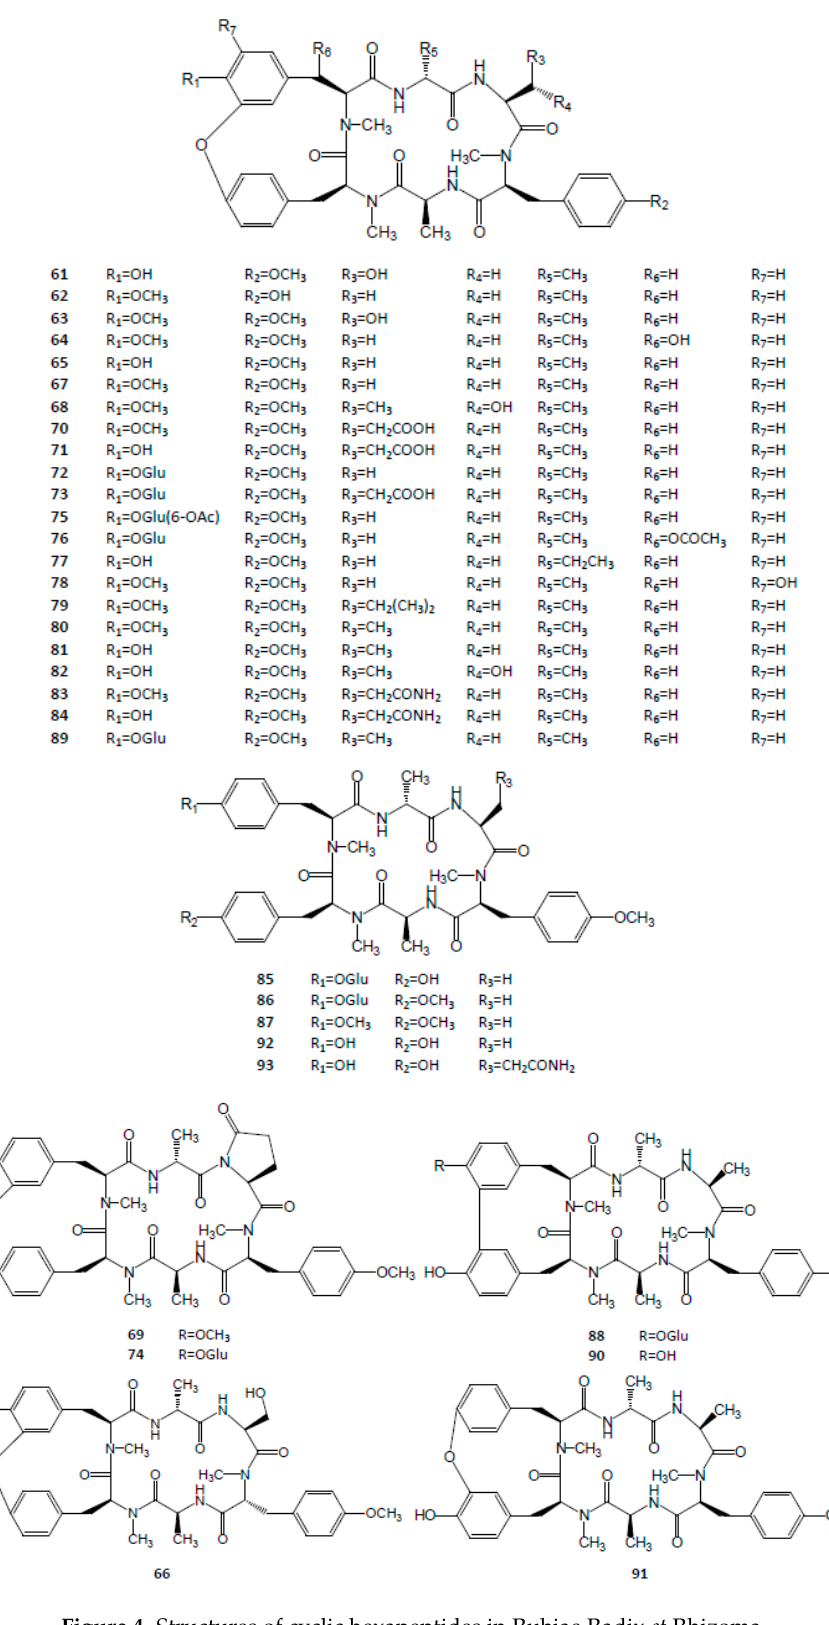
Figure 4. Structures of cyclic hexapeptides in Rubiae Radix et Rhizoma.